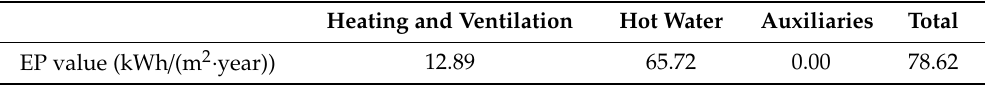
Table 21. The annual EP demand (kWh / (m 2 · year)) for the multi-family building at Akacjowa Street in Goleniow (district heating (Goleniow) + intake-exhaust mechanical ventilation with recovery).